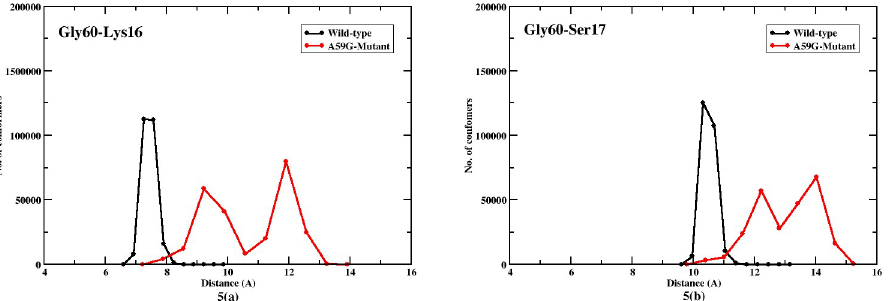
Fig 5. 2-D plot showing number of conformers for Gly60 residue’s interaction with Lys16, and Ser17. Black and red lines represent trends for the wild-type and mutant systems, respectively.